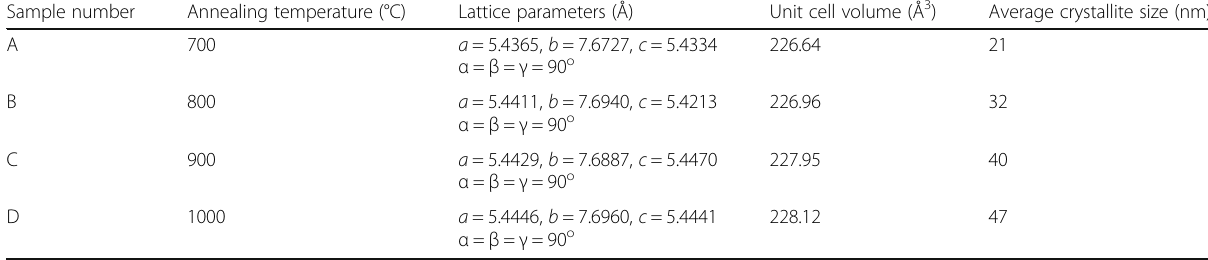
Table 1 The calculated lattice parameters ( a , b , c , α , β , and γ ), unit cell volumes, and average crystallite sizes of the (La 0.6 Pr 0.4 ) 0.67 Ca 0.33 MnO 3 nanoparticles post-annealed at (A) 700 °C, (B) 800 °C, (C) 900 °C, and (D) 1000 °C for 5 h. Lattice parameters within ± 0.0003( a , b , c ) are calculated from the XRD data. Average crystallite sizes within ± 1 are calculated using the Scherrer ’ s